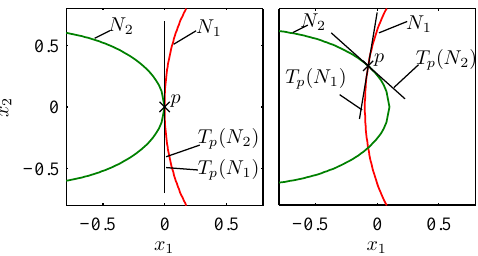
Figure 6: The left subplot shows an intersection that is not transversal; whereas, the right subplot shows aa transversal intersection of two level